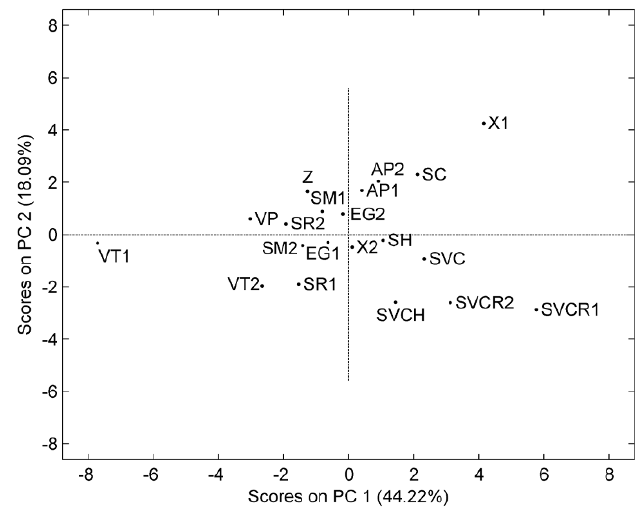
Figure 3. PC1-PC2 score plot for FT-IR data set after SNV+OSC correction.